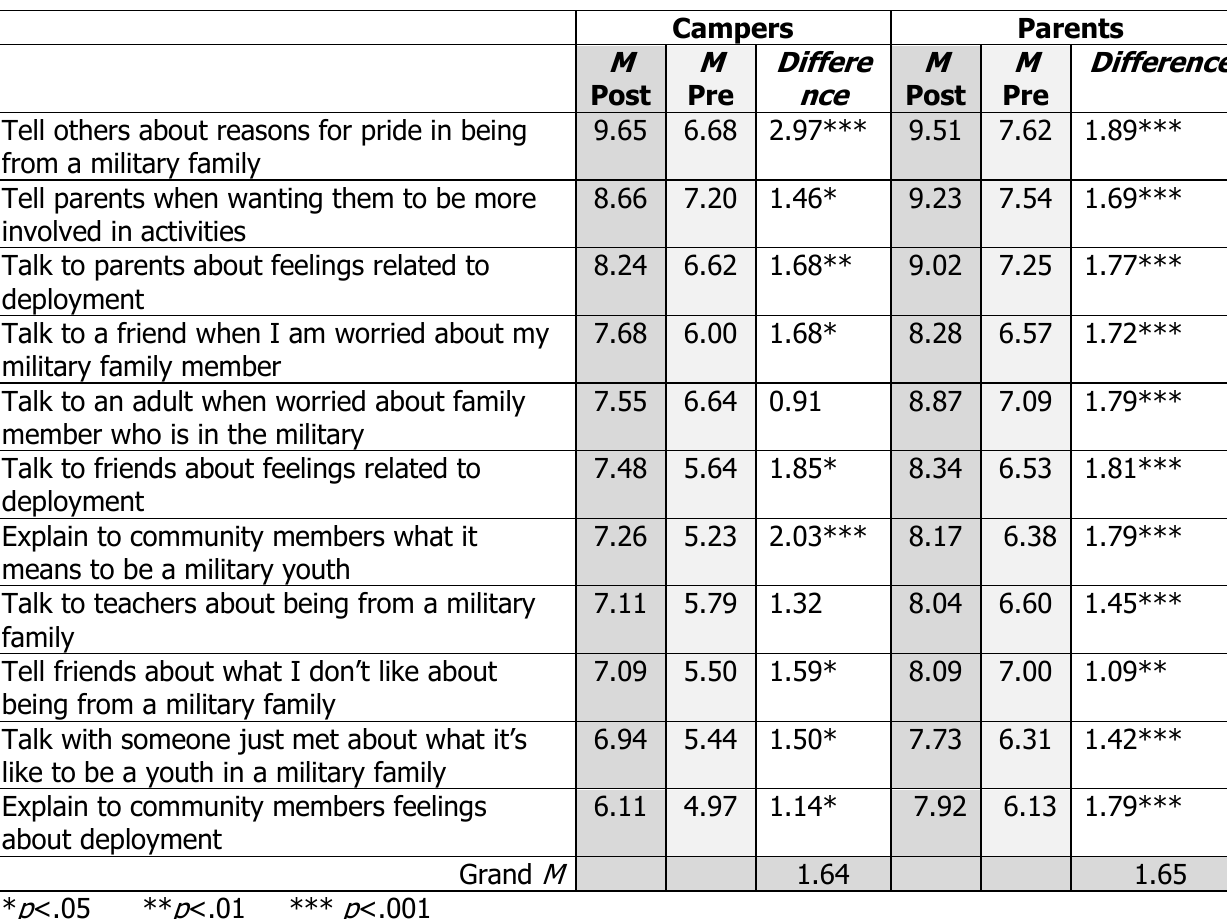
Communication Self-Efficacy: Comparison of Post and Pre Means for Campers